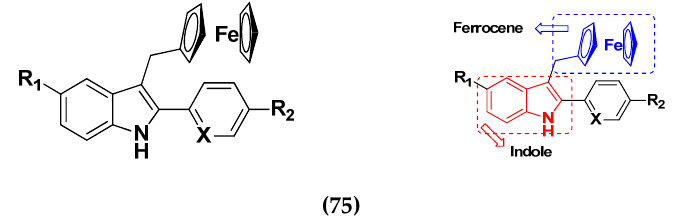
Figure 72. Structure of ferrocene-indole derivatives ( 75 ). Table 61. In vitro cytotoxic activities of ferrocene-indole hybrid compounds 75 ( a – d ). Compounds No.